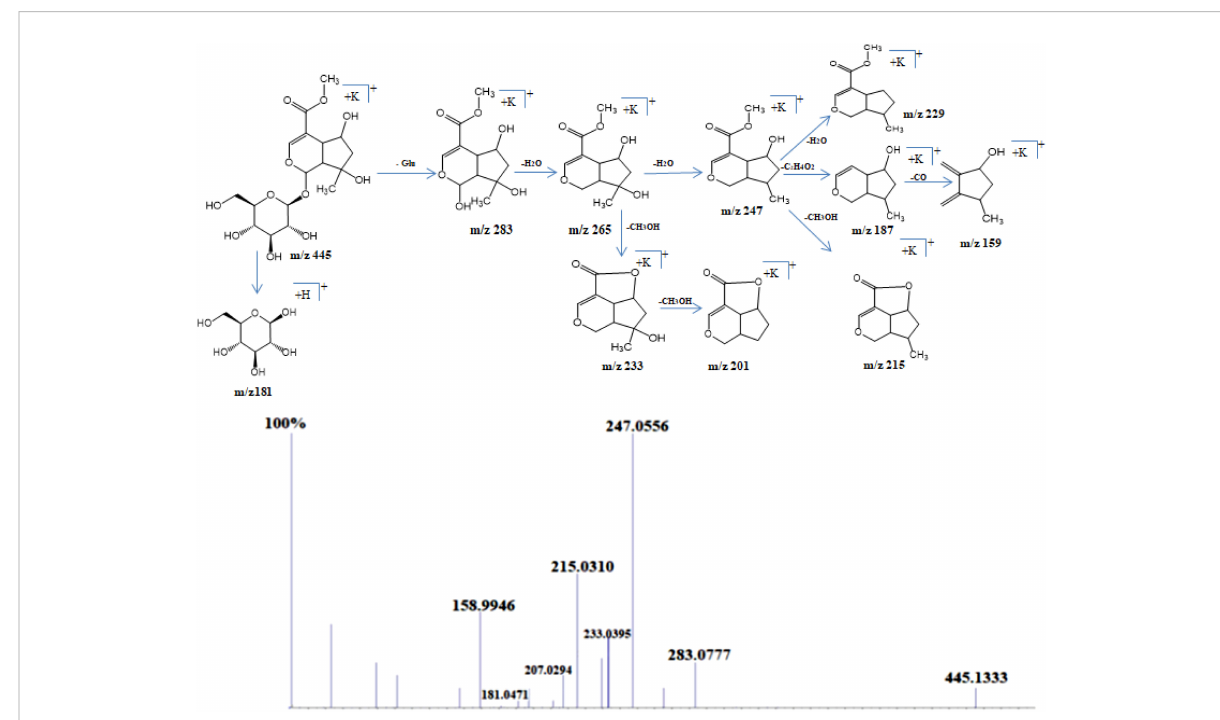
FIGURE 3 Schematic representation of fragmentation pattern of Shanzhiside methylester generated by MS/MS